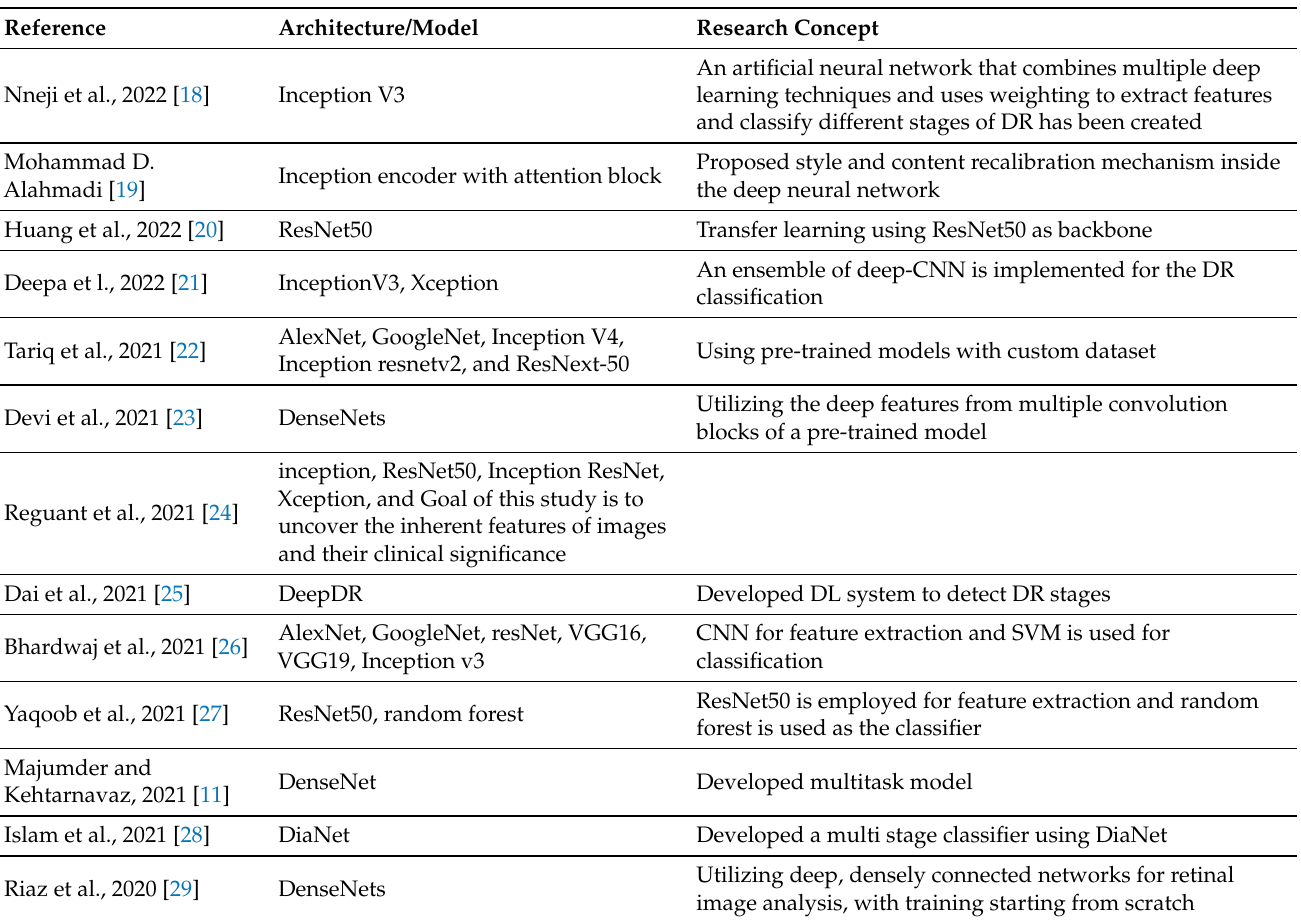
Table 2. Overview of studies on deep learning-based diabetic retinopathy classification.